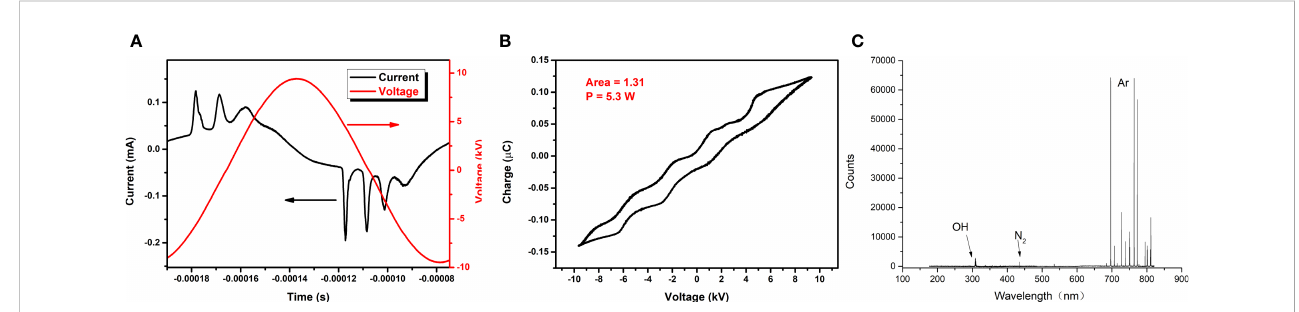
FIGURE 3 (A) Volt – ampere characteristic curve. (B) Lissajous diagram. (C) Diagram of optical emission